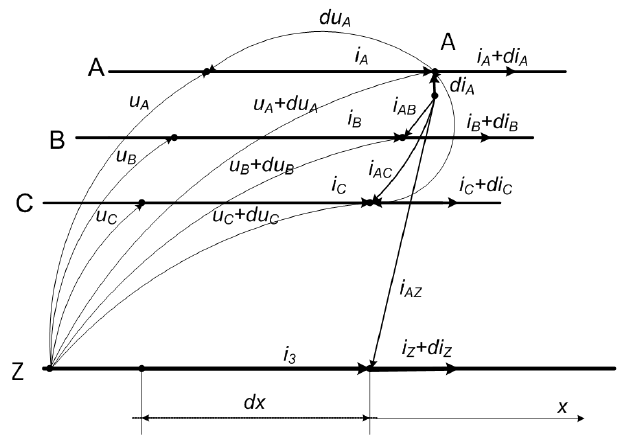
Figure 1. The calculation diagram of the system.